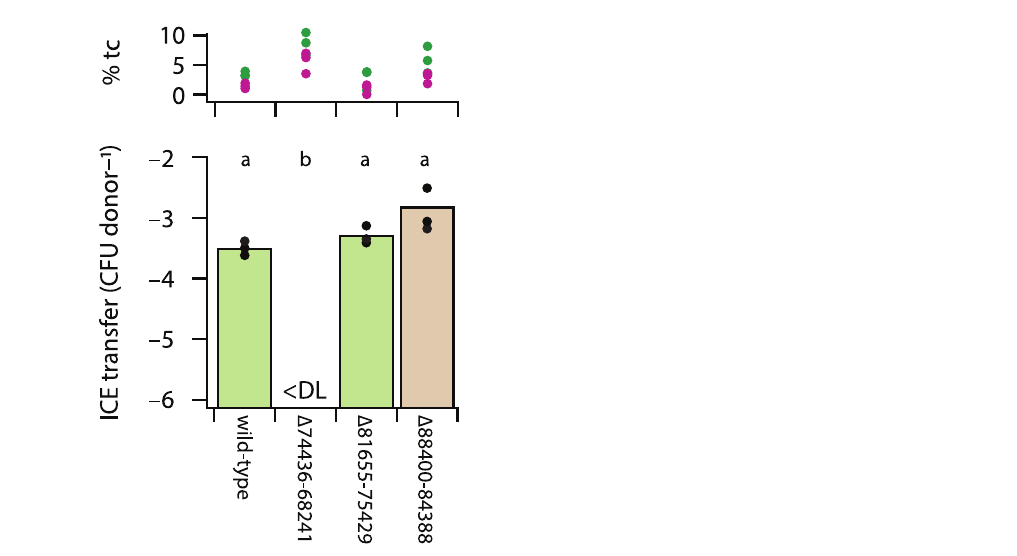
Fig 7. Effect of ICE clc gene region deletions on transfer frequency (bottom) and subpopulation size of P int - mCherry/P inR -eGFP expressing cells (top, as percentage from qq-plots). Bars show the calculated mean ICE transfer frequency (as colony forming units of transconjugants per CFU of the donor) for the indicated ICE in P . putida (deletions as in Fig 1A), with dots representing individual replicate values. Letters correspond to significance values (p < 0.005) in one-factorial ANOVA followed by post-hoc Tukey test. < DL, below detection limit.